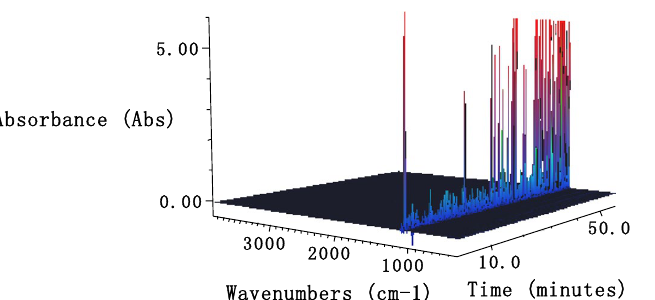
Figure 6. Series 3-D FTIR of gas products from thermal decomposition of